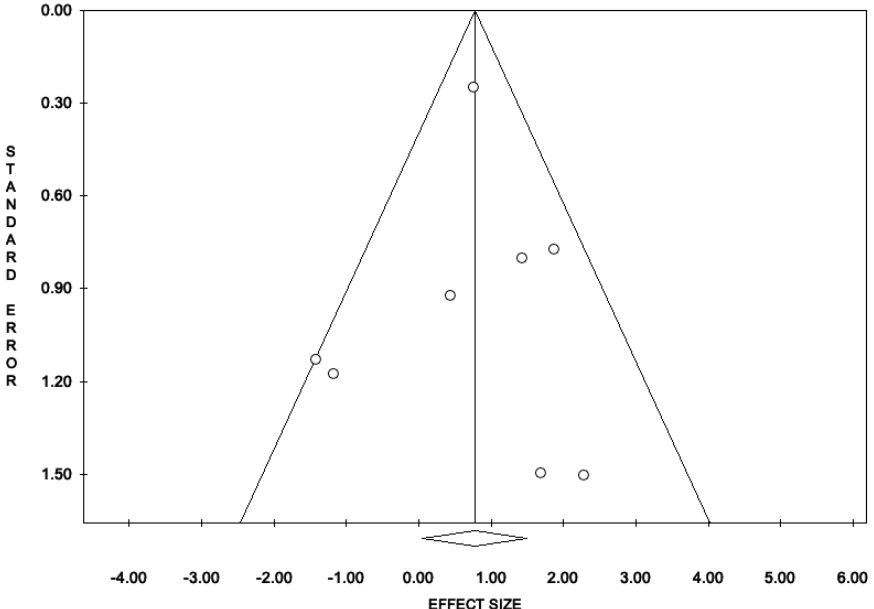
Figure 7. Funnel plots of the meta-analysis evaluating the OR for nausea. Egger’s linear regression (t = − 0.10, p = 0.921) and Begg and Mazumdar rank correlation test (z = − 0.25, p = 0.805).